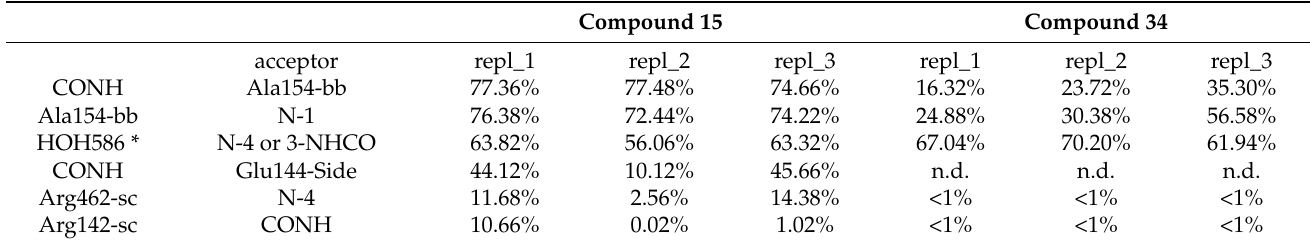
Table 6. Abundance of ligand-receptor hydrogen bonds in the production stage of MD simulation for compounds 15 and 34 . Compound 15 Compound